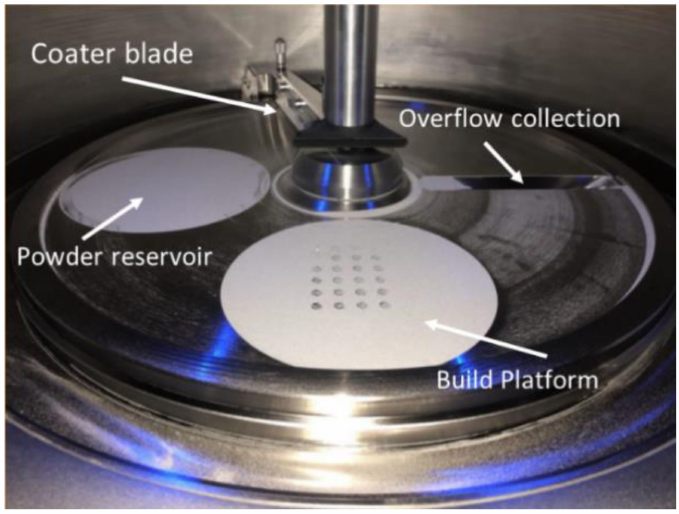
Figure 1. Build chamber architecture in ORLAS CREATOR selective laser melting (SLM)